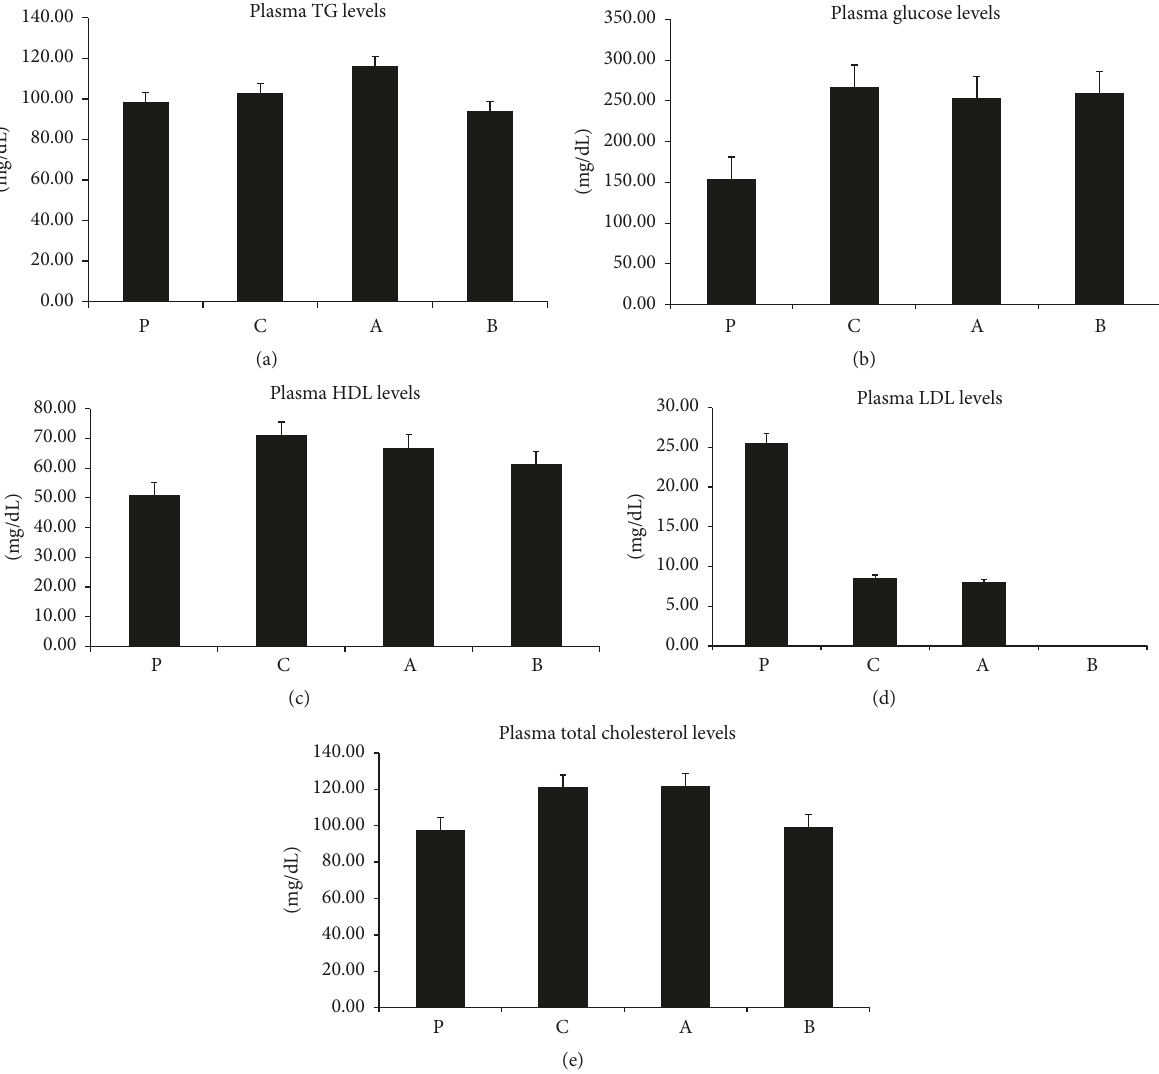
Figure 1: (a) The difference between the plasma levels of triglyceride in the 4 groups was not significant. (b) The difference between the plasma levels of glucose in plain control (Standard Chow) and control (chow supplemented with linoleic acid) is significant ( 𝑃 < 0.01 ); glucose also significantly ( 𝑃 < 0.01 ) decreased in higher concentration of OxLA compared to the plain chow. However the low oxidized LA has shown significantly ( 𝑃 < 0.01 ) increased glucose compared to the plain group. (c) Plasma HDL levels increased among all the treated groups; they were however more significant ( 𝑃 < 0.05 ) between the plain and control group and the LA and higher OxLA group ( 𝑃 < 0.01 ). (d) Higher OxLA plasma LDL levels were significantly ( 𝑃 < 0.01 ) reduced compared to the LA control. Plasma LDL was also greatly reduced in low OxLA compared to the plan and control groups. However the difference was not significant. (e) Total cholesterol plasma levels increased in LA and the low OxLA groups compared to the plain control and higher OxLA groups; however the difference was not significant. 1(a)–1(c) and 1(e)), with the exception of LDL (Figure 1(d)), which was